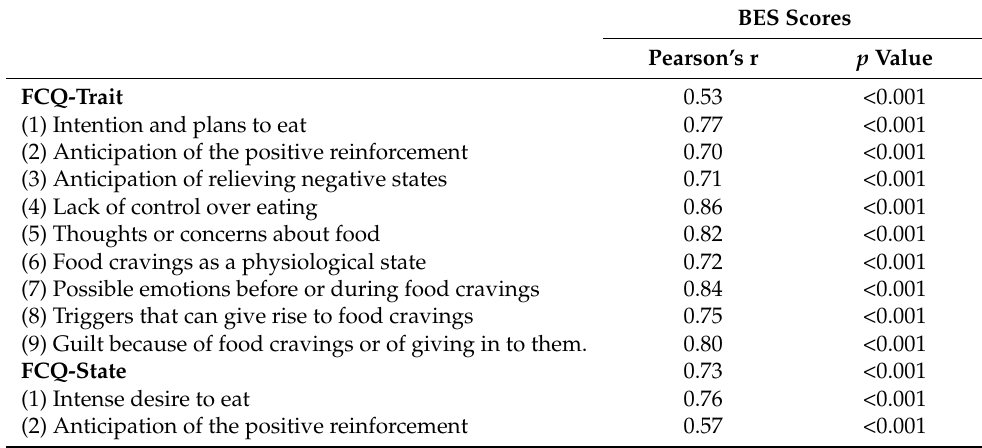
Table 2. Pearson’s correlations with binge eating levels (low-carb group, n =